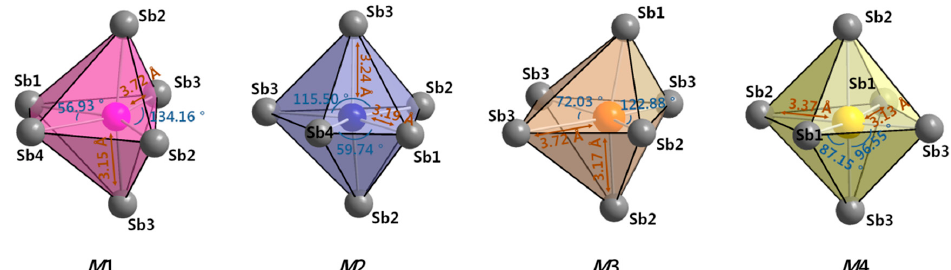
Figure 2. Four octahedral cation sites in the Yb 14- x Ca x AlSb (4.81(3) ď x ď 10.57(2)) series displayed as